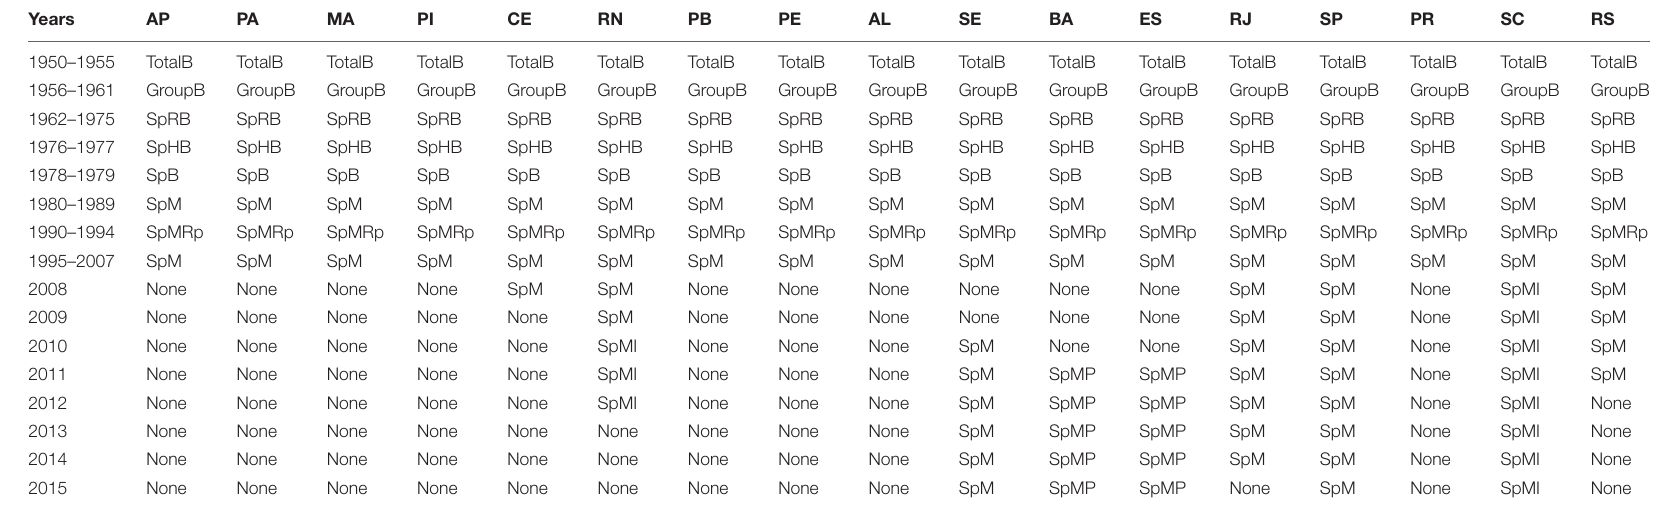
TABLE 1 | Type of data available to proceed with the reconstruction of landings for Brazilian marine waters for the period 1950–2015. Years